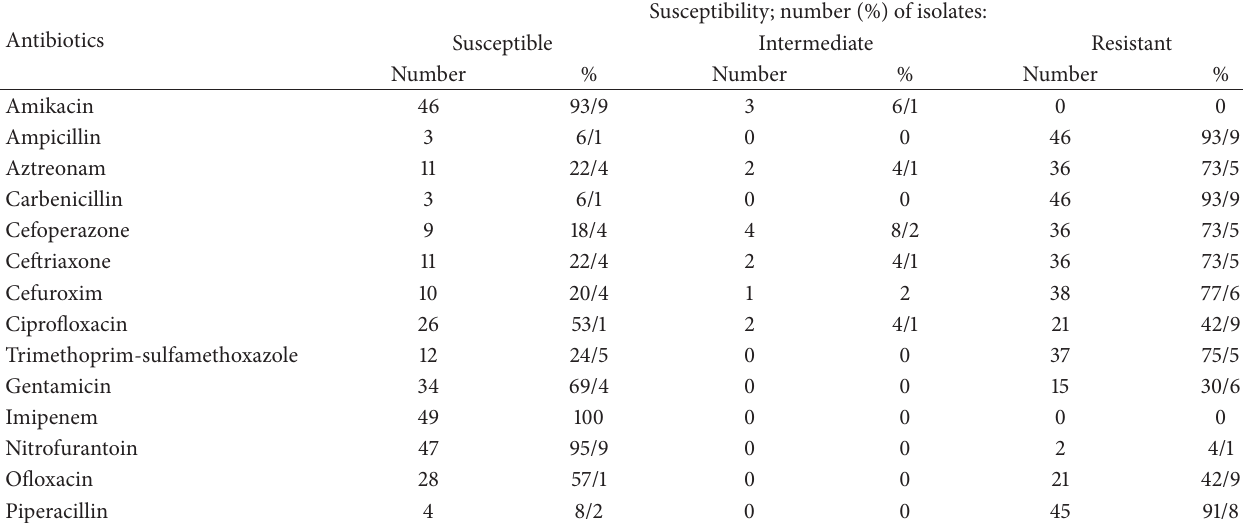
Table 1: Antimicrobial-susceptibility for UPEC strains.